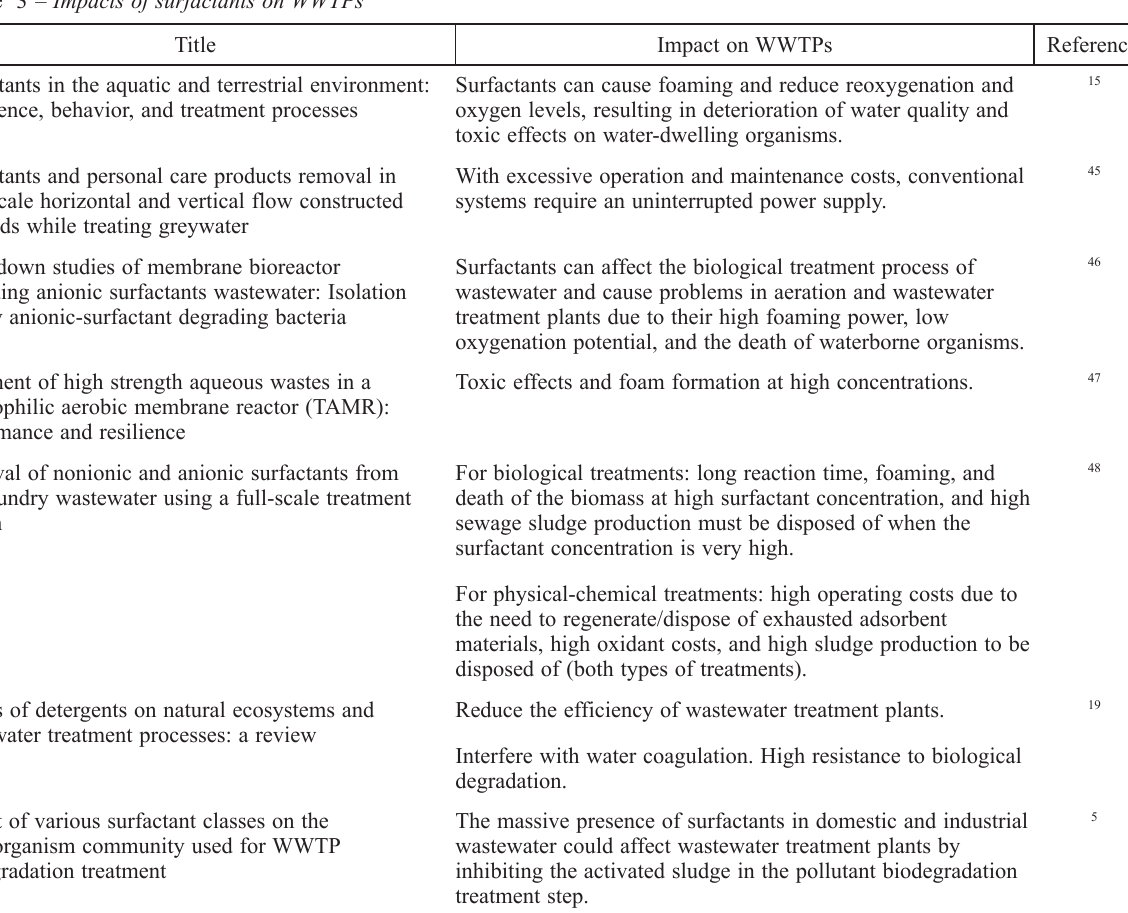
Table 3 – Impacts of surfactants on WWTPs